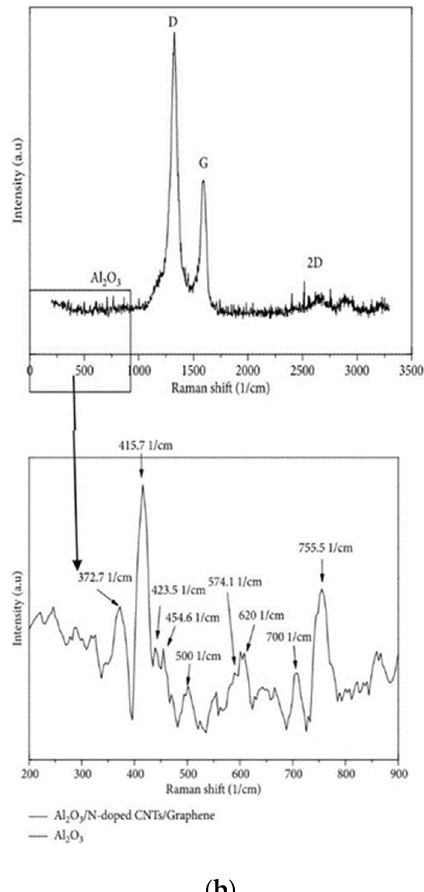
Figure 3. ( a ) The N-doped carbon nanotubes/graphene composite Al 2 O 3 /N-doped carbon nano- tubes/graphene at different cycles on the charge specific capacity of 0.1 C. ( b ) Rate capability (be- tween 0.01 V and 3 V) with different cycles for the N-doped CNTs/graphene composite and Al 2 O 3 /N-doped CNTs/graphene [35].